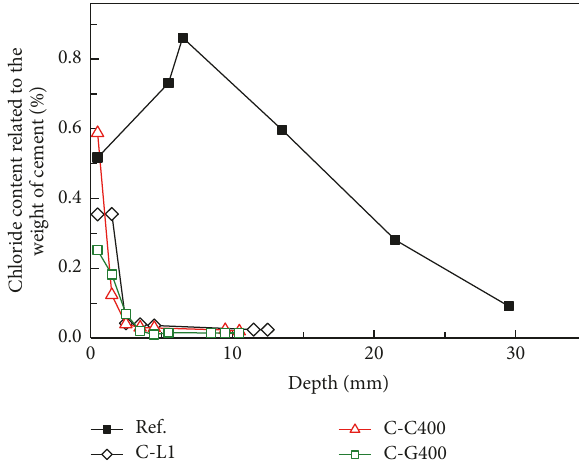
Figure 9: Water content in surface impregnated and water saturated mortar specimens G100, G400, and G600. For comparison, the water distribution in untreated mortar is also shown.